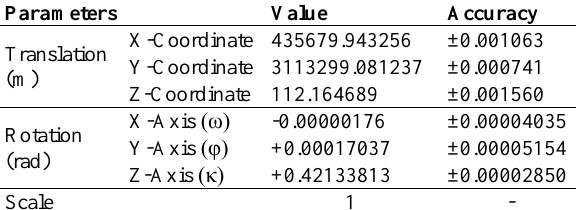
Table 1. Estimated values and associated precision of the parameters of the transformation between both reference